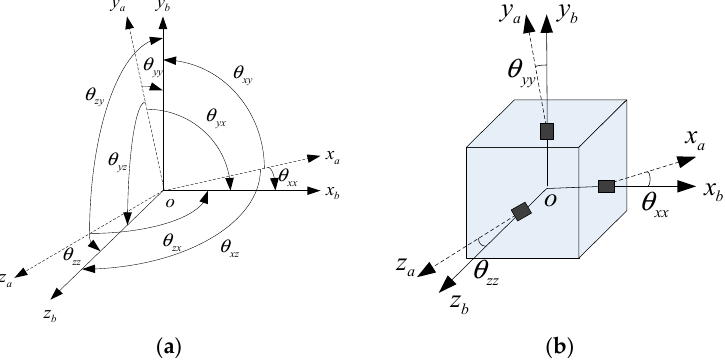
Figure 1. Model of static calibrate for accelerometer unit: ( a ) angles between a-frame and b-frame; ( b ) installation of tri-accelerometer unit.